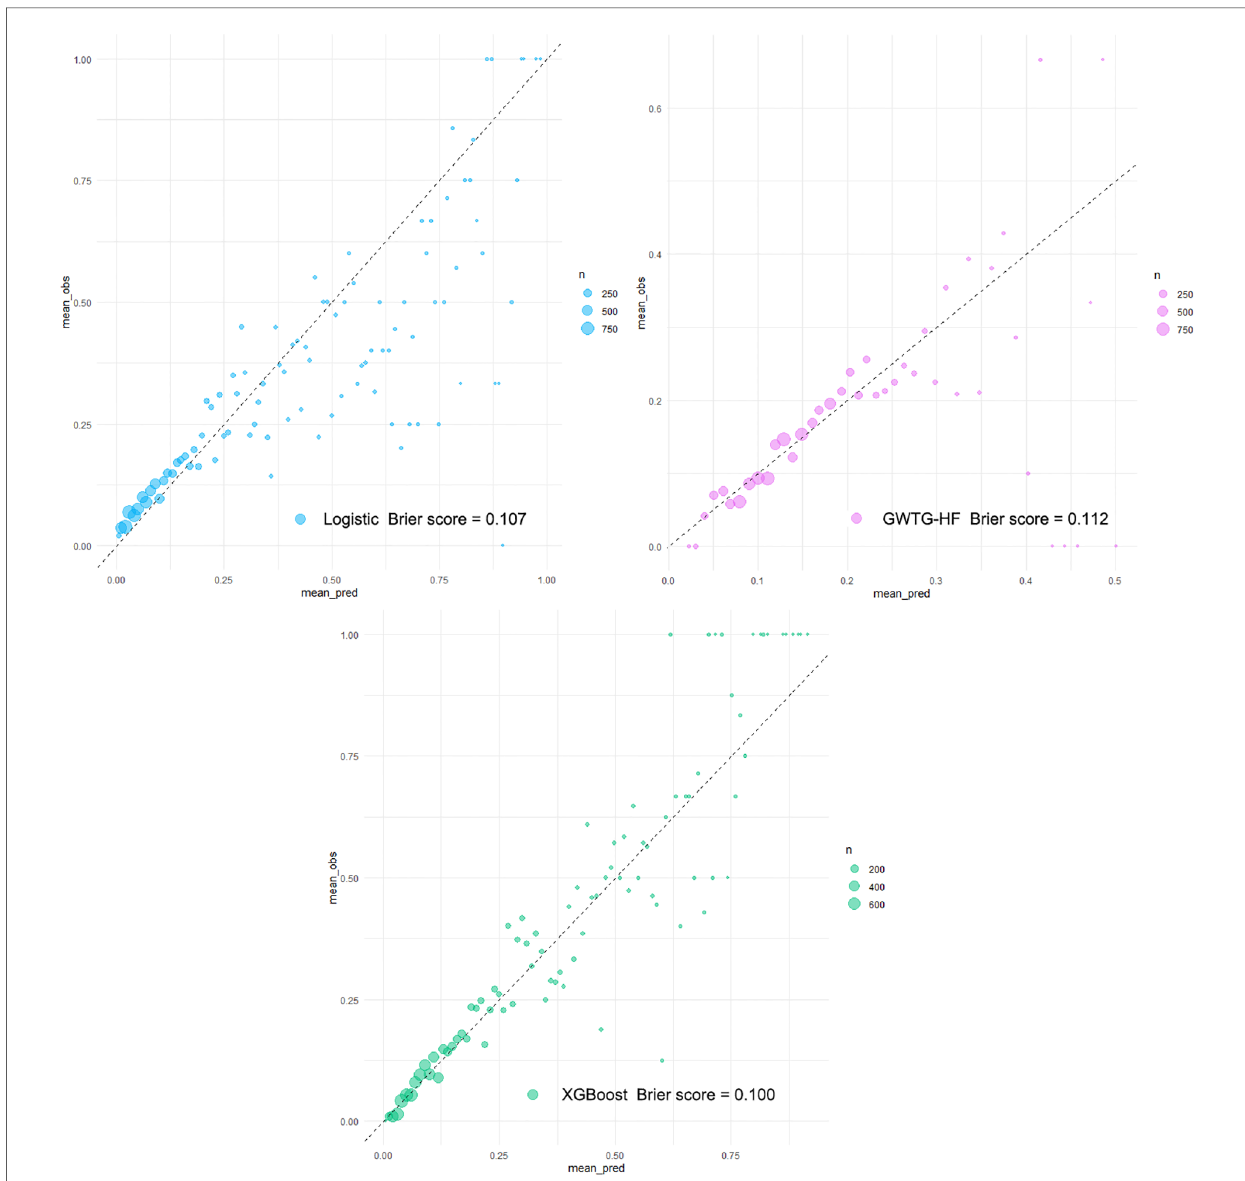
FIGURE 5 Calibration plots of all models in testing dataset. Calibration plots of predicted probabilities ( X -axis) and actual proportions ( Y -axis) for different prediction models. With the calibration slope closest to 1.0 (an ideal model), the eXtreme Gradient Boosting ( XGBoost model ) from the machine learning algorithm obtained a fairly satisfactory calibration, while the other models calibrated